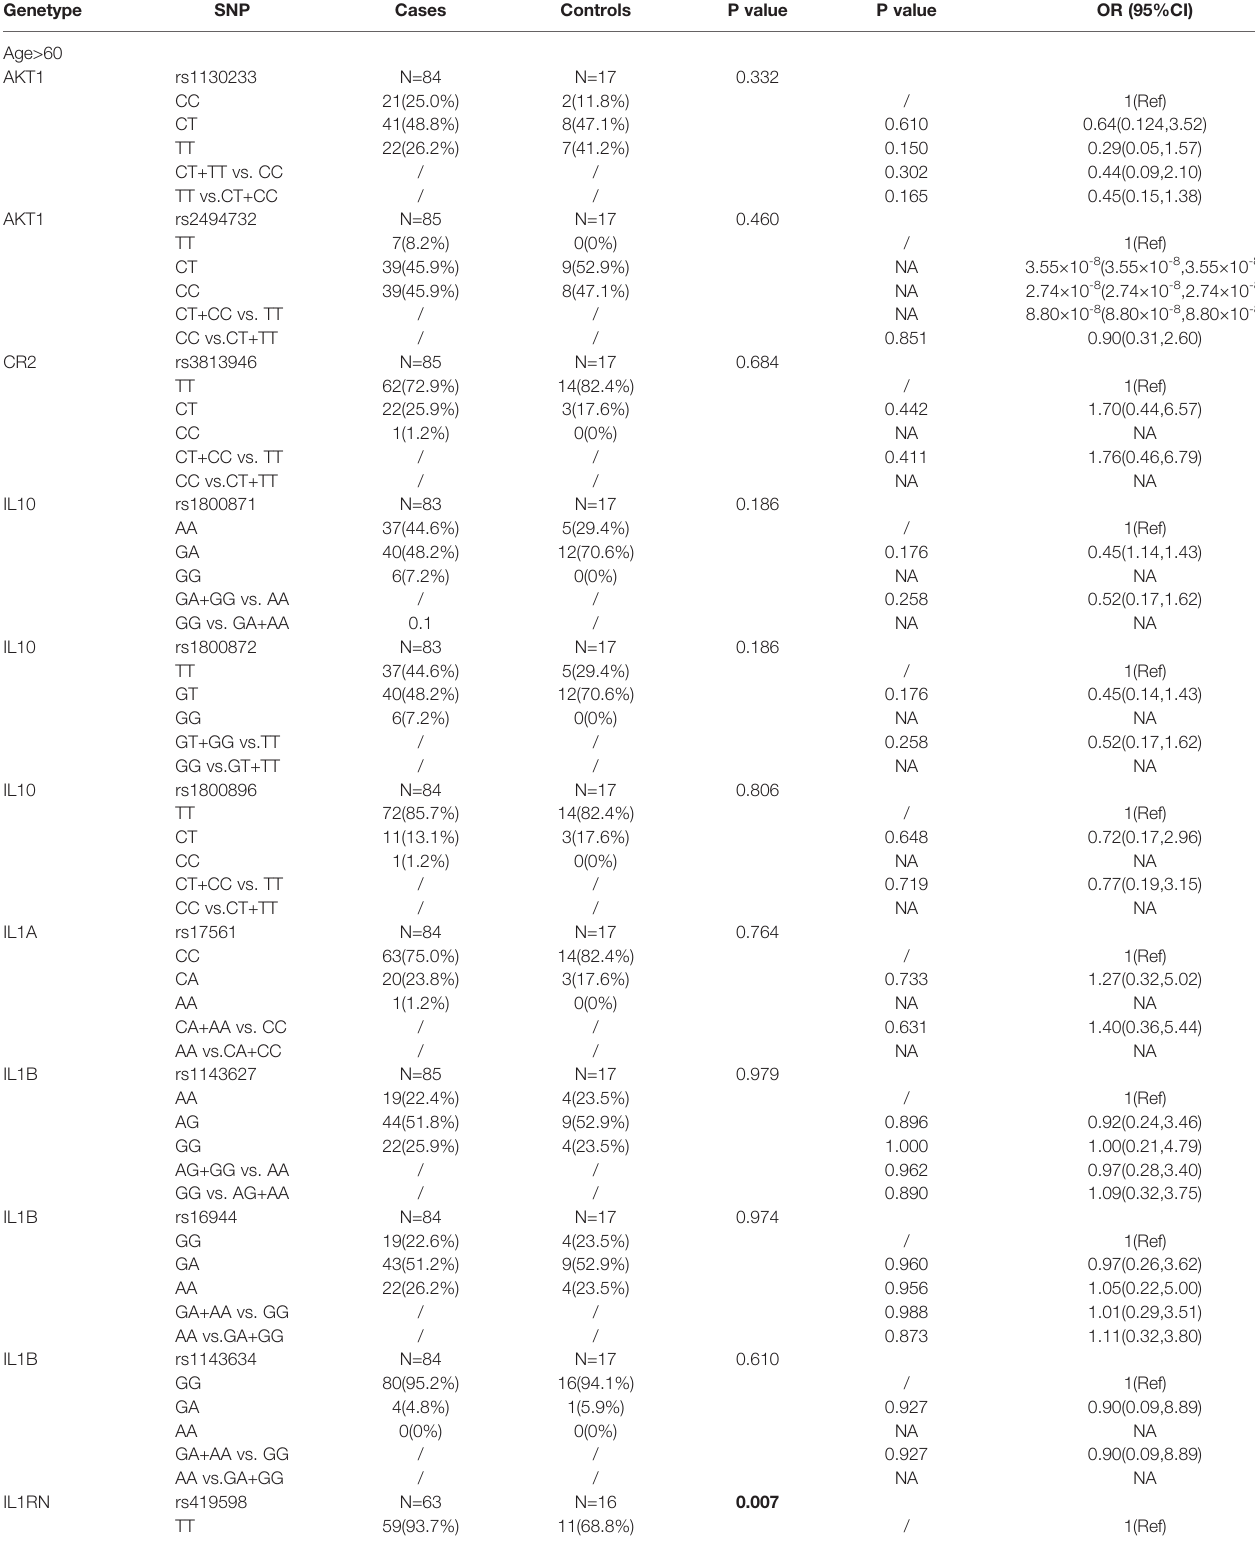
TABLE 3 | Strati fi ed analysis of the association of 28 in fl ammation-associated gene SNPs with HNSCC risk.